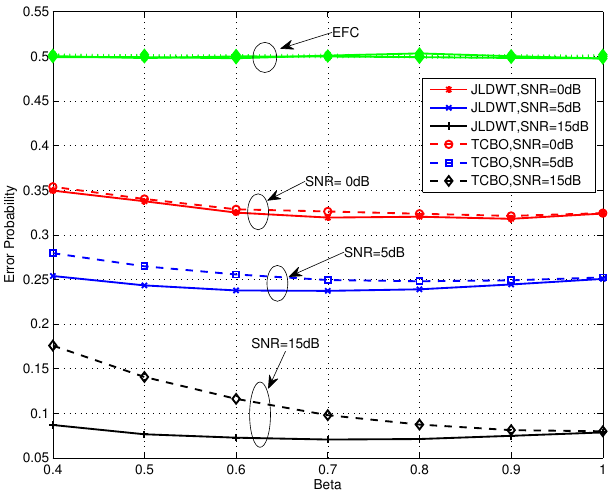
Figure 10. Error probabilities of TCBO and JLDWT schemes with SC based LLR as functions of various β for snr L = 0